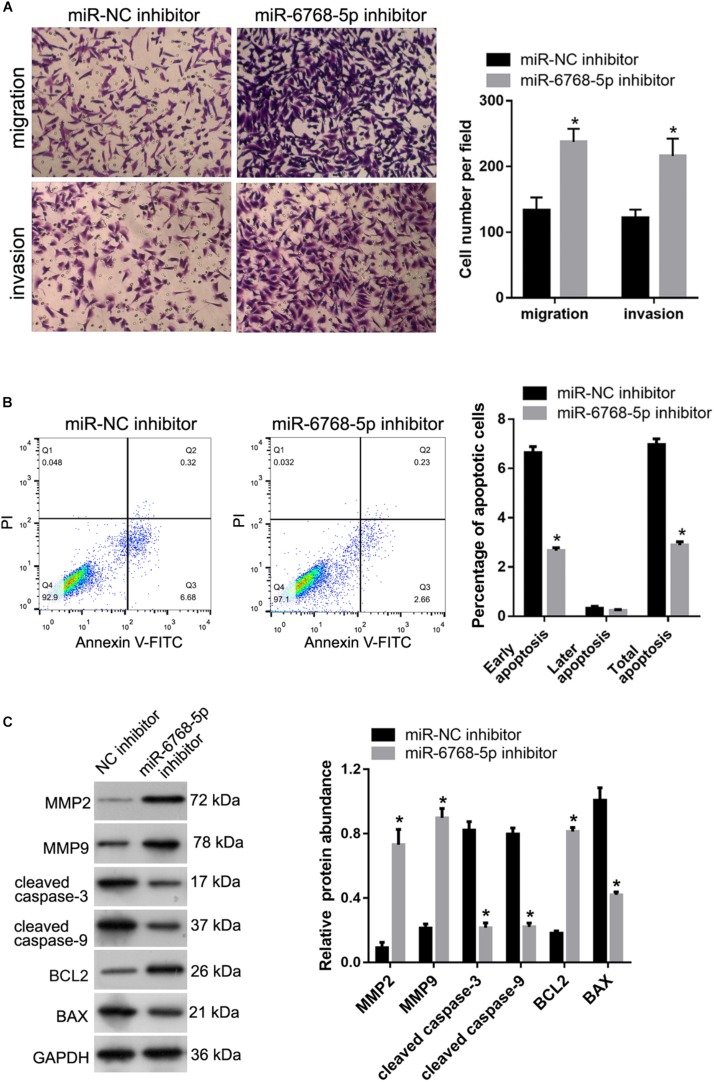
Effect of hsa-miR-6768-5p knockdown on apoptosis, migration and invasion of HTR-8 cells. miR-6768-5p inhibitor was transfected into HTR-8 cells to knockdown hsa-miR-6768-5p. miR-NC inhibitor was transfected as a control. (A) The results of the Transwell assay. The left panel includes representative images of migration and invasion by the Transwell assay. The right panel includes bar graphs of the quantification of migrated or invaded cell numbers. (B) Effect of hsa-miR-6768-5p knockdown on apoptosis. The left panel shows quantification of the percentage of apoptotic cells. The right panel shows representative graphs of the apoptosis detected using a flow cytometer. (C) Effect of hsa-miR-6768-5p knockdown on protein abundance of MMP-2, MMP-9, cleaved caspase-3, cleaved caspase-9, BCL2, and BAX in HTR-8 cells. The left panel includes representative images of western blots. The right panel graphs represent the quantification of relative protein expression levels. *P < 0.05 unpaired t-tests.